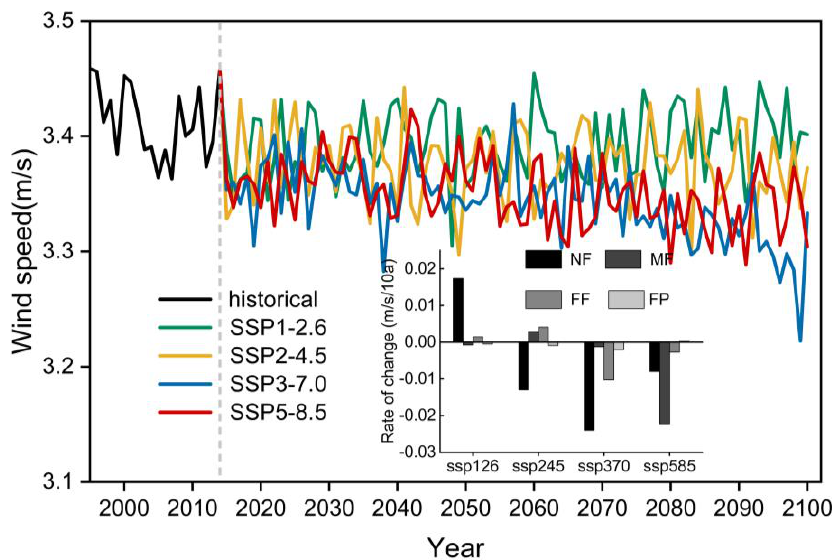
Figure 4. Variations in projected annual wind speed in the ARNC from 1995 to 2100 under different emission scenarios. The black bar chart shows the variation trend of surface wind speed in NF, MF, FF and FP.